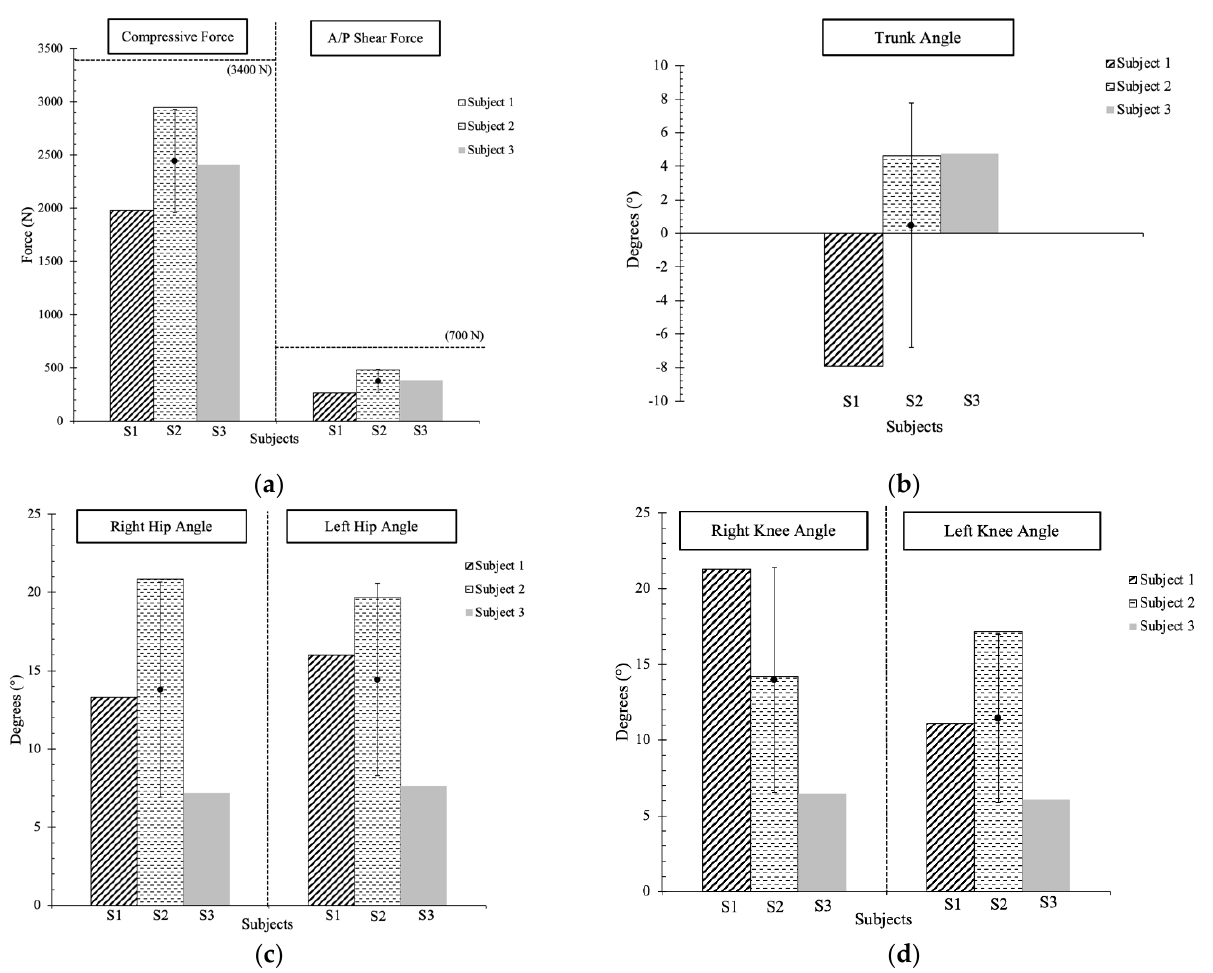
Figure 6. The analyzed results at Pose#2 in Task#1: ( a ) the exposed spinal forces with the recom- mended safety threshold values; ( b ) the trunk angles; ( c ) the hip angles; ( d ) the knee angles.